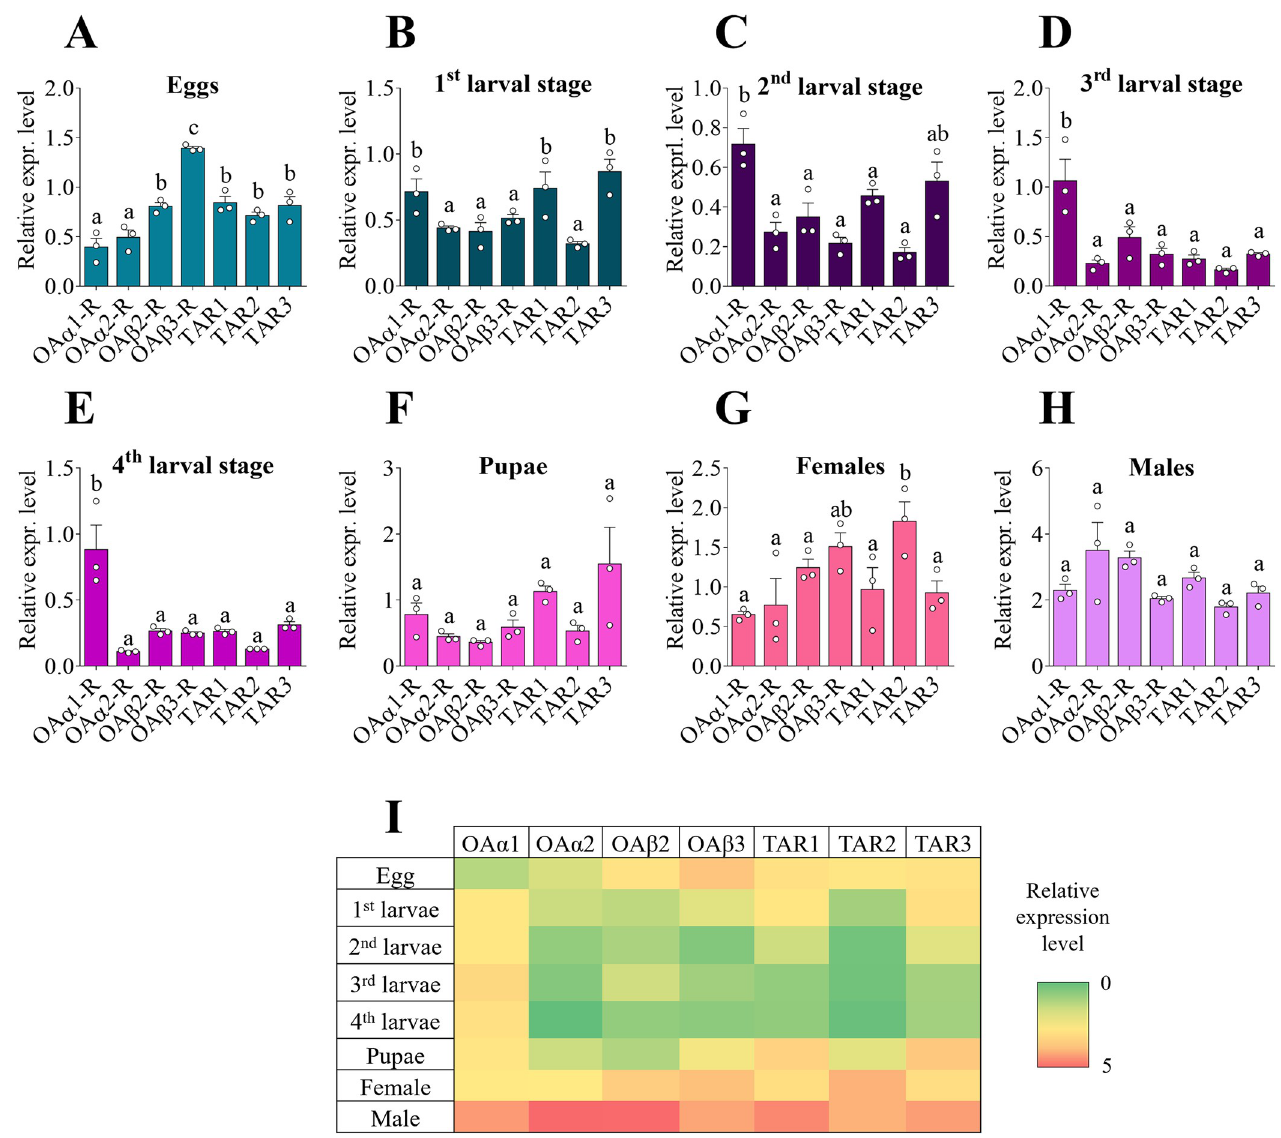
Fig 2. Expression patterns of A . aegypti OA and TA receptor transcripts over development stages. Eggs ( A ), 1 st larval stage ( B ), 2 nd larval stage ( C ), 3 rd larval stage ( D ), 4 th larval stage ( E ), pupae ( F ), adult female ( G ) and adult male ( H ). The data obtained from all the development stages is also represented as a heat map ( I ). Data represent means ± SEM of three biological replicates. One-way ANOVA followed by multiple comparisons Bonferroni post hoc test were performed. Statistical significance of p < 0.05 is indicated by different letters in panels A-H.